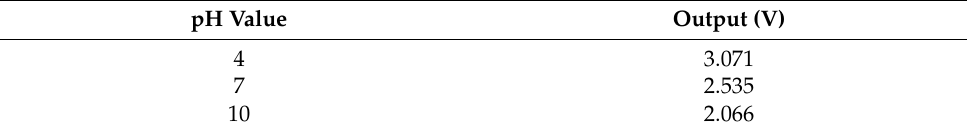
Table 3. pH value and output voltage relevance.